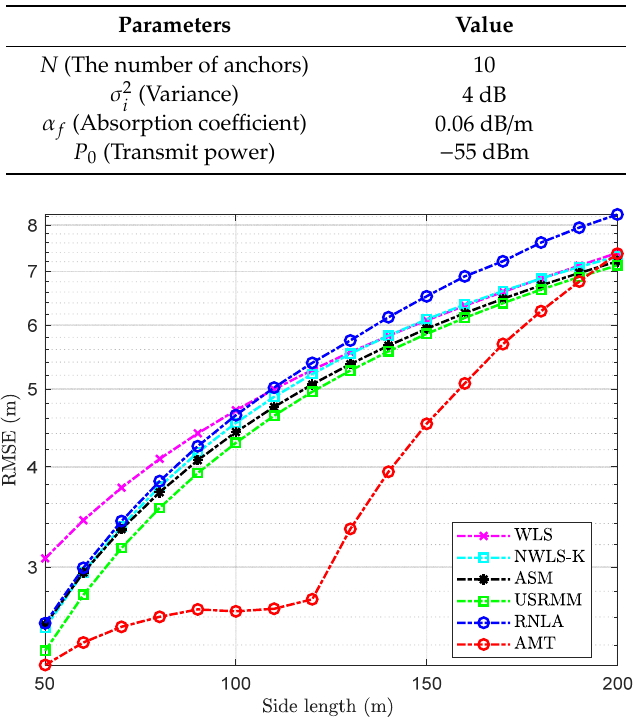
Figure 9. RMSE versus variable side length with N = 10, σ 2 4 dB − 55 dBm. 0